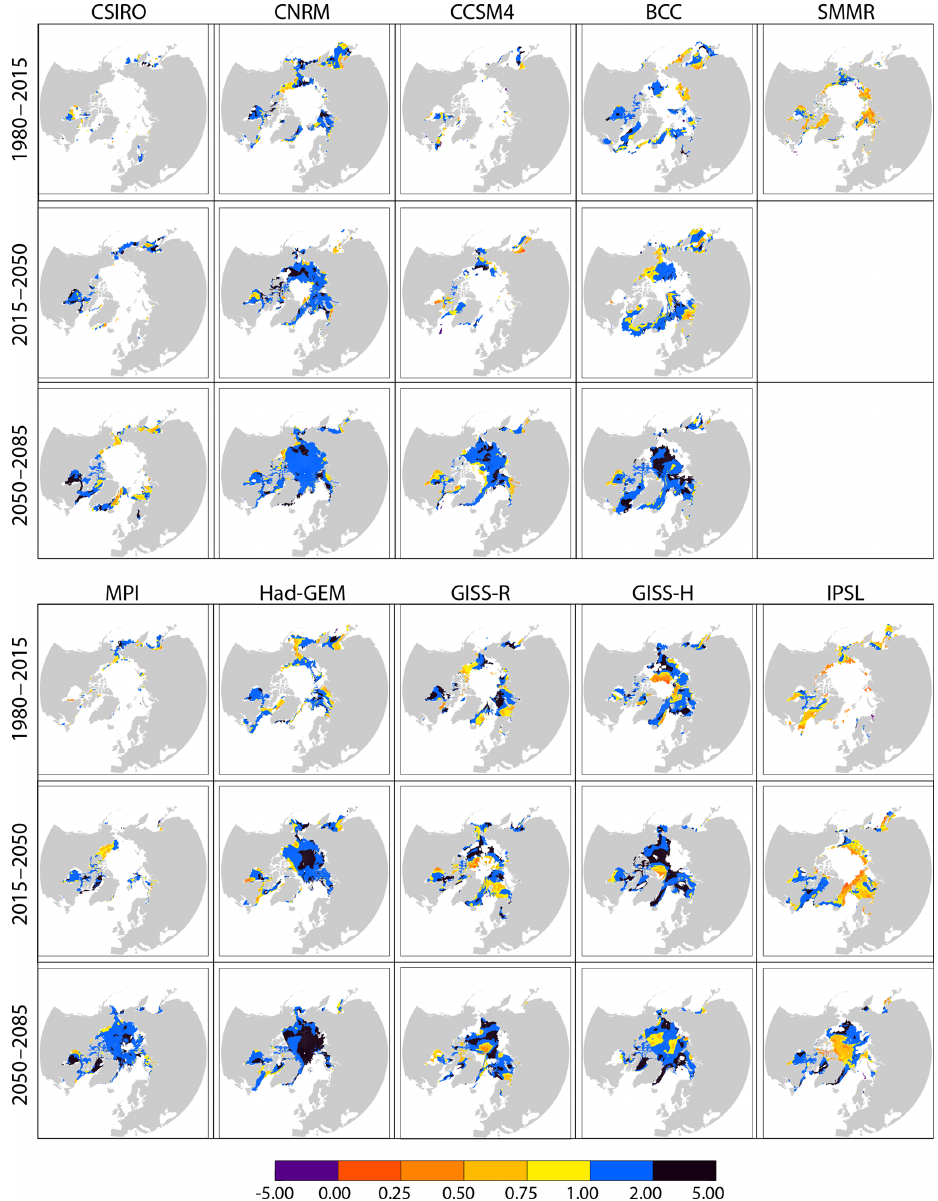
Figure 4. Long-term ice advance vs. retreat amplification coefficient from passive microwave ice concentration retrievals (SMMR; over 1980–2015), and for all individual models over 1980–2015, 2015–2050 and 2050–2085. We use a 75% ( p = 0 . 25) confidence interval for this specific computation. Similar figures (for SMMR and IPSL_CM5A_LR only) for p = 0 . 05 are available in the Supplement (Fig. S9).